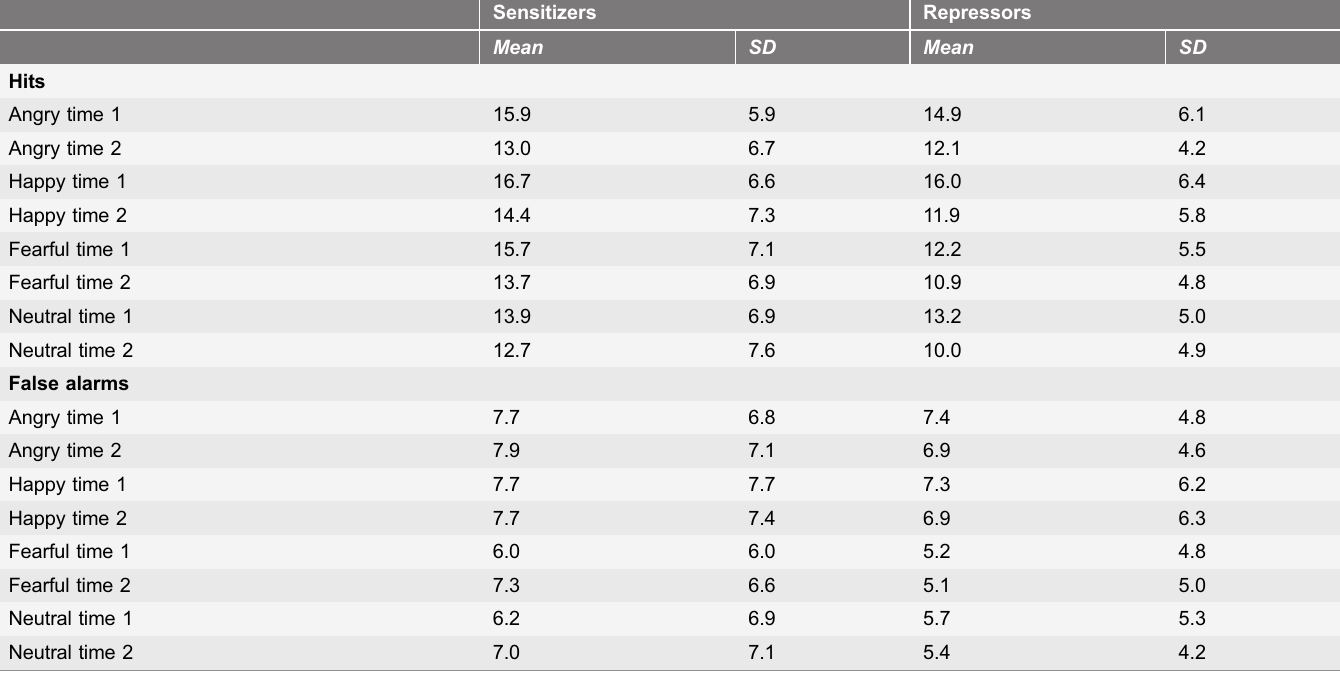
Table 3. Immediate (time 1) and delayed (time 2) recognition performance as a function of facial expression and coping style (number of correct recognitions (hits) and false alarms). Sensitizers Repressors Mean